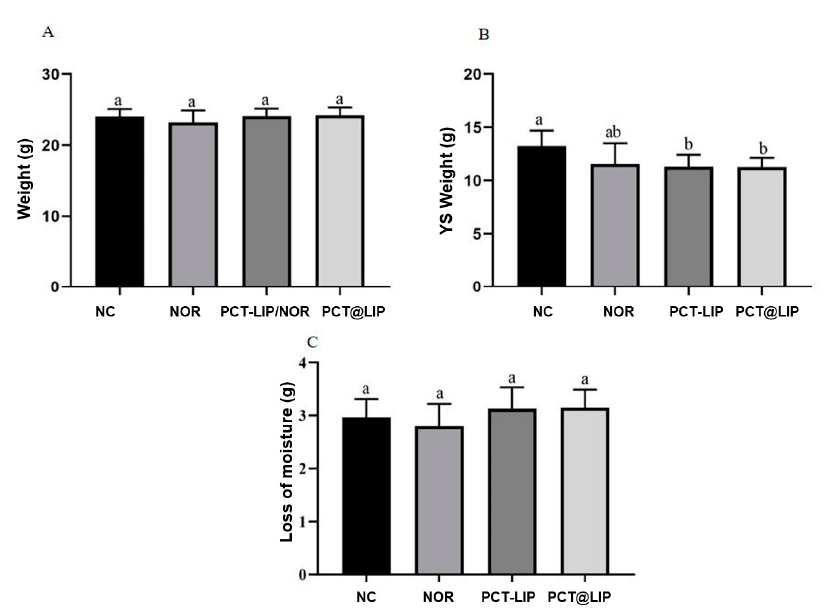
Figure 4. In vivo toxicity study in terms of chicken embryo weight ( A ), YS weight ( B ) and loss of moisture ( C ), in chicken embryos after treatment with norfloxacin (20 μ g/mL) or formulations containing 20 μ g/mL NOR. NC = negative control, NOR = 20 μ g/mL norfloxacin solution, PCT-LIP = liposome encapsulating NOR (20 μ g/mL) blended with pectin solution and PCT@LIP = pectin-liposome formulation containing NOR (20 μ g/mL), n = 10. Different letters indicate significant difference ( p < 0.05) and values are expressed as mean ± SEM (One-way ANOVA followed by Tukey test).